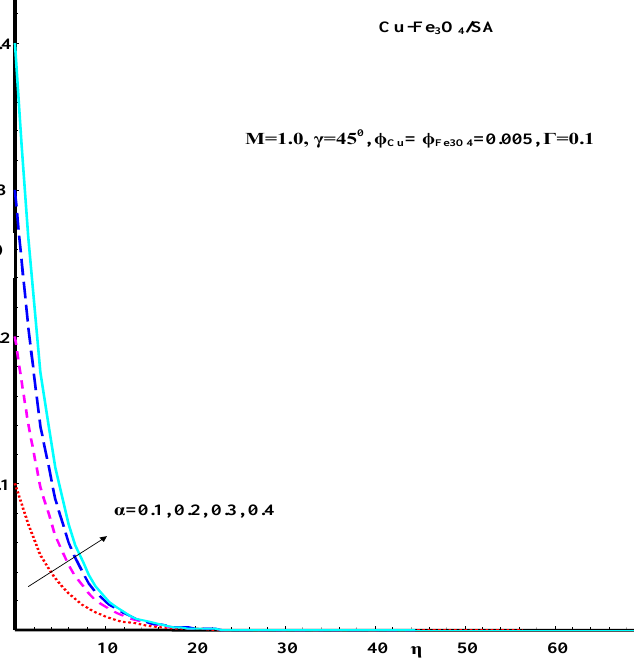
Figure 2. Effect of stretching ( α > 0 ) case on velocity